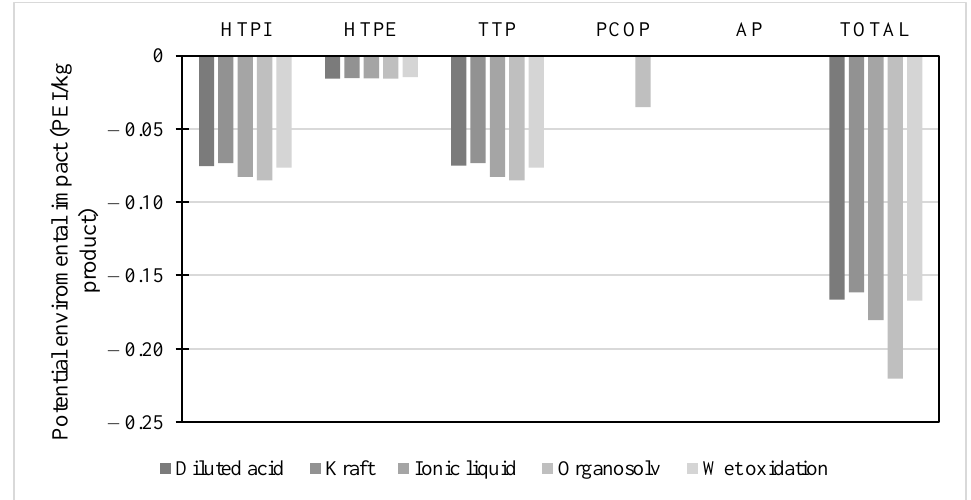
Figure 2. Potential environmental impact of pretreatment schemes for cellulose isolation. The environmental impact of the pretreatment schemes for the isolation of the hemi- cellulose fraction is presented in Figure 3. The pretreatment schemes that exhibited the greatest environmental benefit were the ionic liquid and steam explosion in the human im- pact categories and the greenhouse gas emissions. Therefore, the organosolv pretreatment, although it contemplates using solvents, does not present pollutant gas emissions due to the recovery or recirculation of the solvent. This analysis also applies to the ionic liquid pretreatment, with the recirculation of the main process reagent. On the other hand, the ARP pretreatment showed the lowest favorable index due to the use of ammonia during the reactive process. Different authors have previously reported the effects of ammonia on the ecosystem and human health [70]. Thus, organosolv pretreatment and steam explosion are the best environmental schemes for hemicellulose recovery.